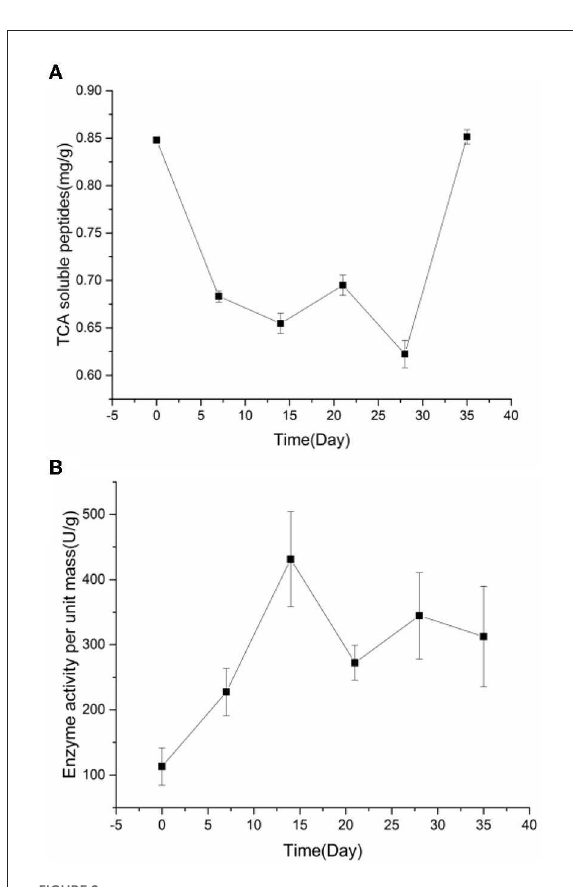
FIGURE2 The changes of TCA soluble peptide contents (A) and the endogenous protease activity (B) in preserved egg yolk during